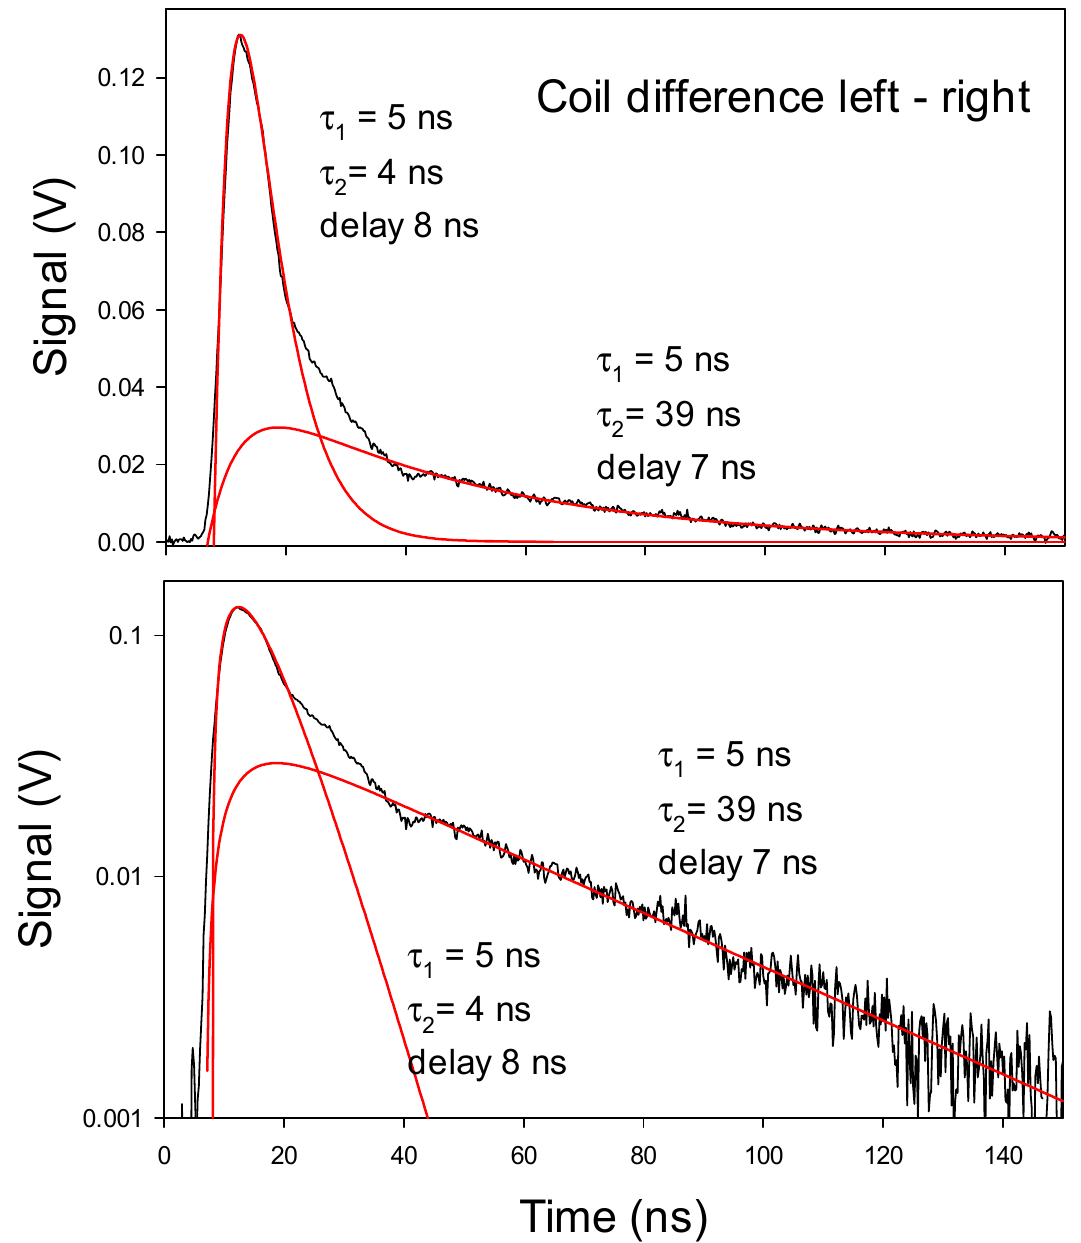
Figure 5. Linear and logarithmic plots of the same data using a current coil for detection. Short-lived neutral kaons and time-dilated charged pions are detected. D(0), 0.2 mbar D 2 . Current coil at 58 cm from target. 0.4 J, 10 Hz pulse repetition, 1064 nm light.